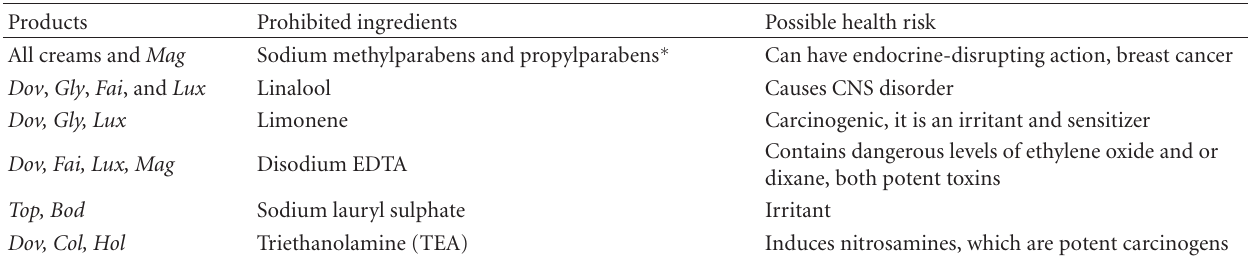
Table 5: Prohibited ingredients identified due to their health e ff ects among the cosmetics commonly used in Jimma town [36, 37]. Products Prohibited ingredients Possible health risk All creams and Mag Sodium methylparabens and propylparabens